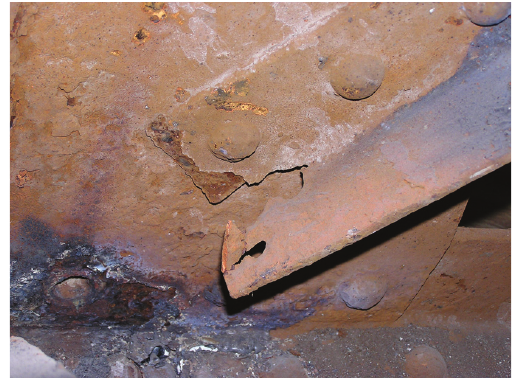
Fig. 5. A severely corroded railway bridge element